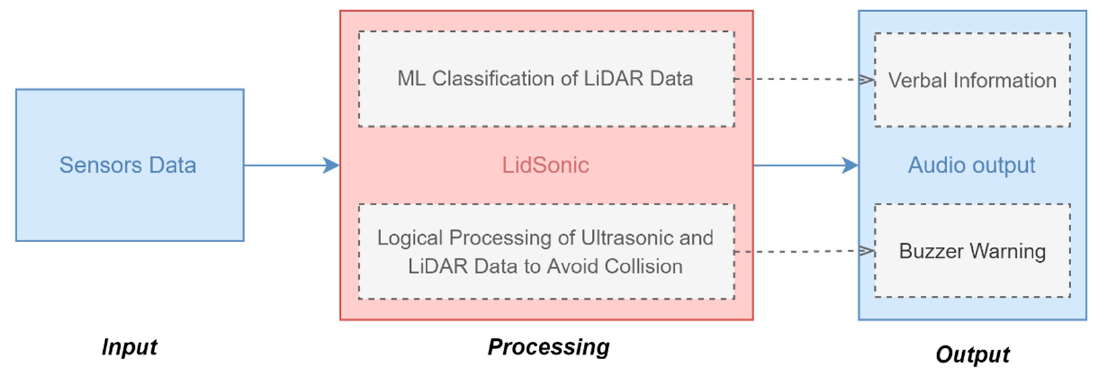
Figure 4. LidSonic system: a high-level view.